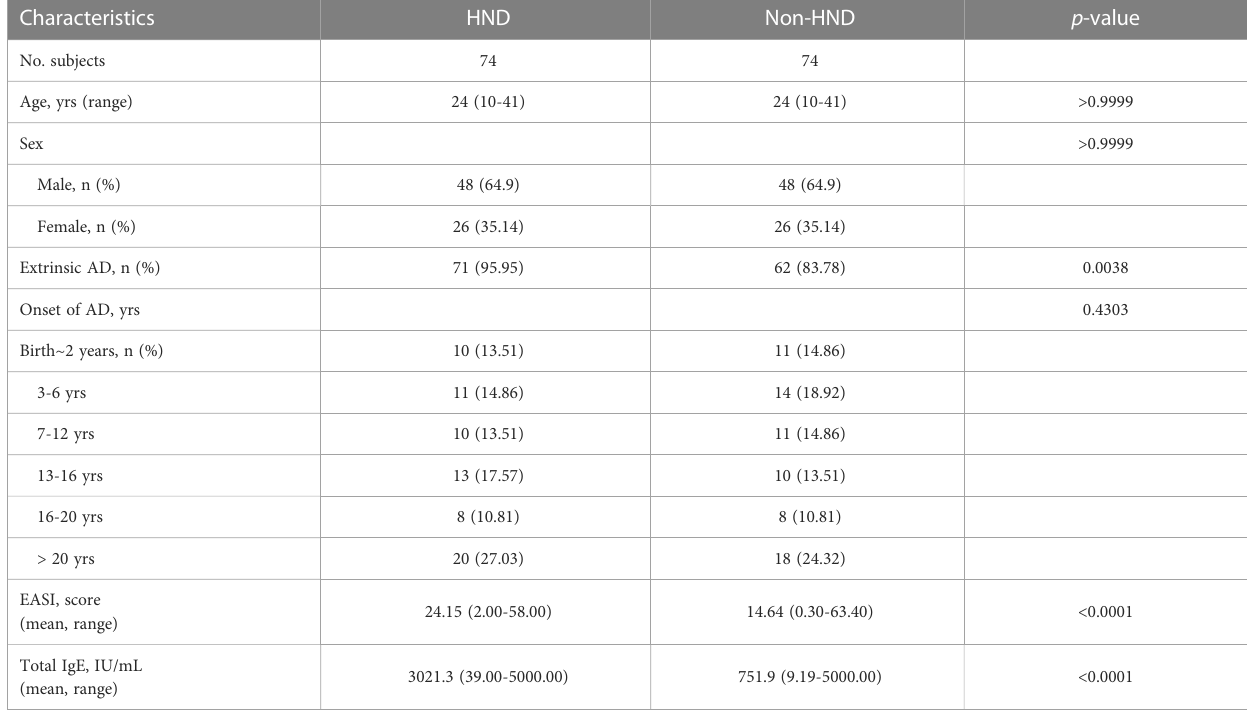
TABLE 1 Comparison of epidemiological and laboratory characteristics of HND and Non-HND patients.